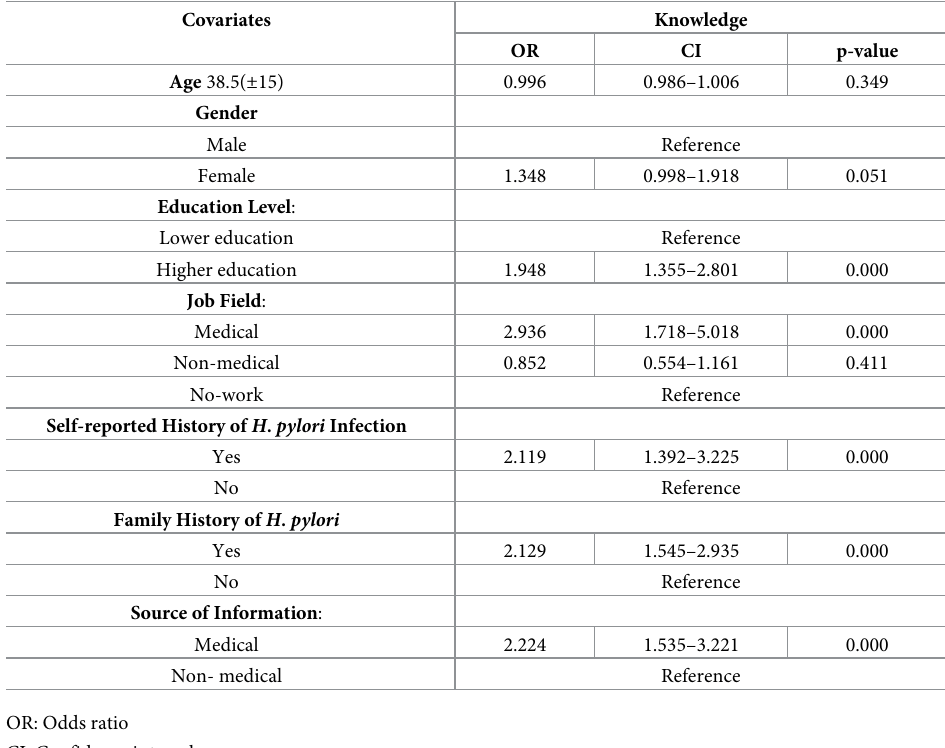
Table 3. Multivariate logistic regression associations between knowledge and the sociodemographic characteris- tics of the general population in